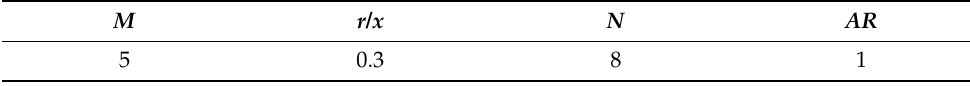
Table 4. Crack tip modeling guidelines suggested through SIF sensitivity analysis.